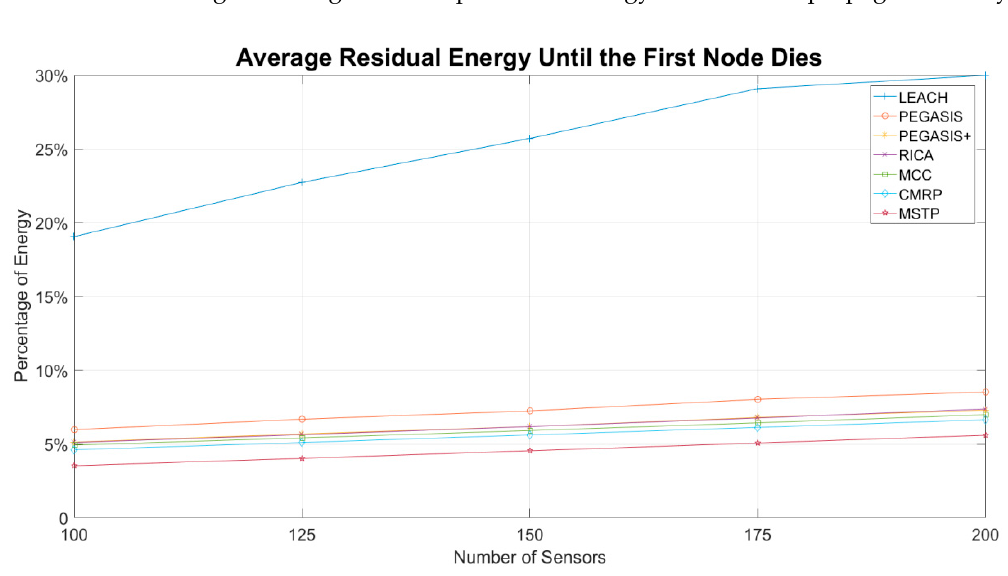
Figure 7. Average residual energy until the first node dies.